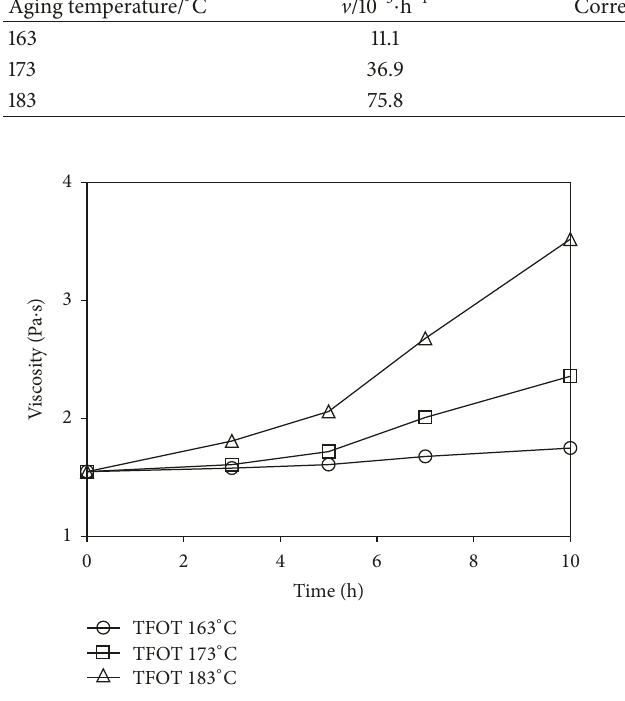
Figure 4: Variation curve of viscosity of modified asphalt with the change of aging